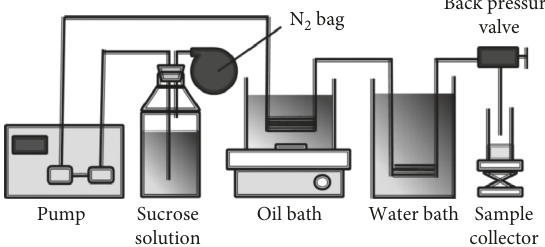
Figure 1: Schematic illustration of the reaction system for sucrose decomposition under hydrothermal